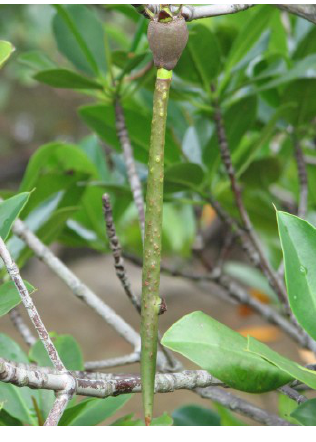
Figure 9. Rhizophora mucronata